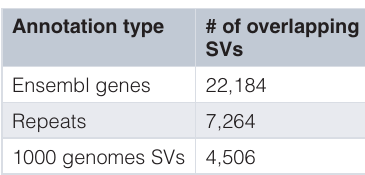
Table 2. Summary over the overlapping annotation for the SVs data